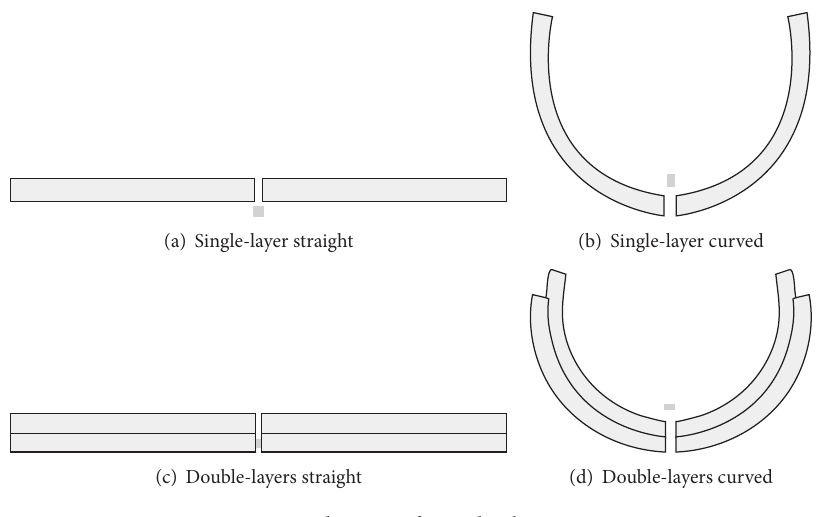
Figure 3: Schematic of strip dipole antenna.